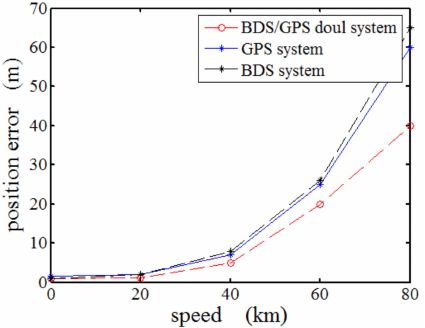
Figure 12. The relationship between positioning error and vehicle